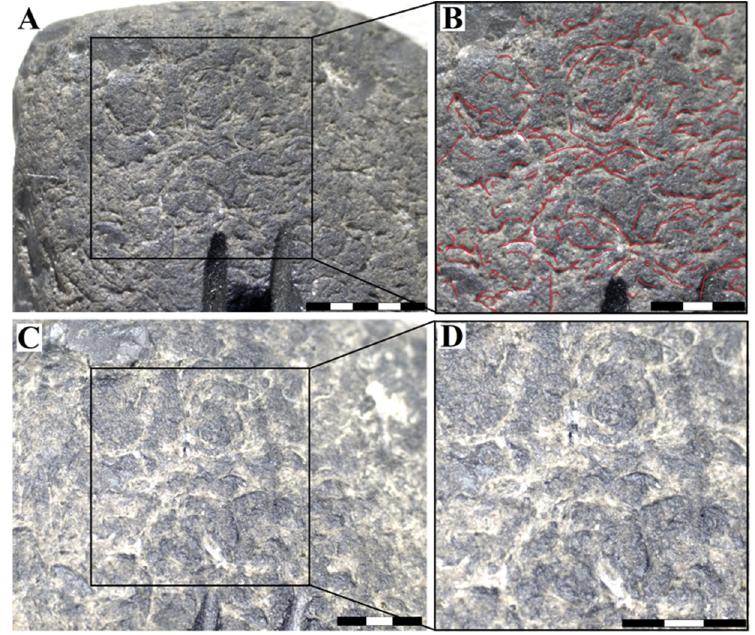
Figure 4. Details of the cortex of artifact 15-P0006-230812, knapped in dacitic glass. In the incision in the lower part of Figure 3A, the black color of the rock can be observed. ( A , B ) Normal photographs, and ( C , D ) stereomicroscope images. Each white and black rectangle is 1 mm long.